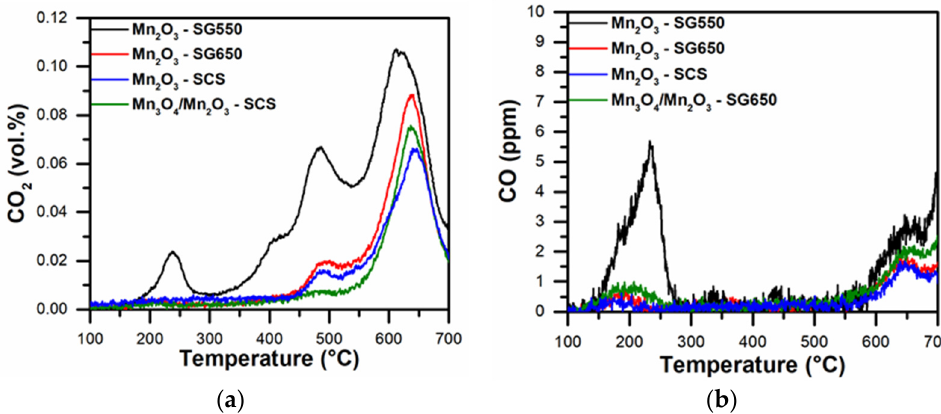
Figure 4. ( a ) CO 2 and ( b ) CO profiles observed during the soot-TPR analyses of the prepared catalysts.